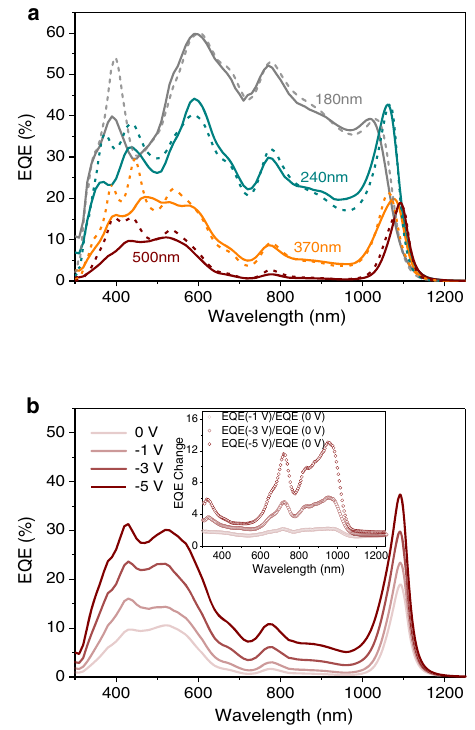
Fig. 4 | Narrowband EQE modeling and mechanismstudy. a Zero biasmeasured EQE spectra (solid lines) of ITO (135nm)/PDIN(15nm)/PCE10:COTIC- 4F(180 – 500nm)/MoO 3 (15nm)/Ag (100nm) devices with various active layer thicknesses. The dash lines present the best EQE fi ts using TMM model. η here is 0.85, determined by scaling the calculated absorption in SCR to match the mag- nitude of the experimental EQE. b EQE spectraof a 500 nm thick PCE10:COTIC-4F inverted device with a PDIN interlayer under different reverse bias. Inset isthe EQE change determined by EQE (bias)/EQE